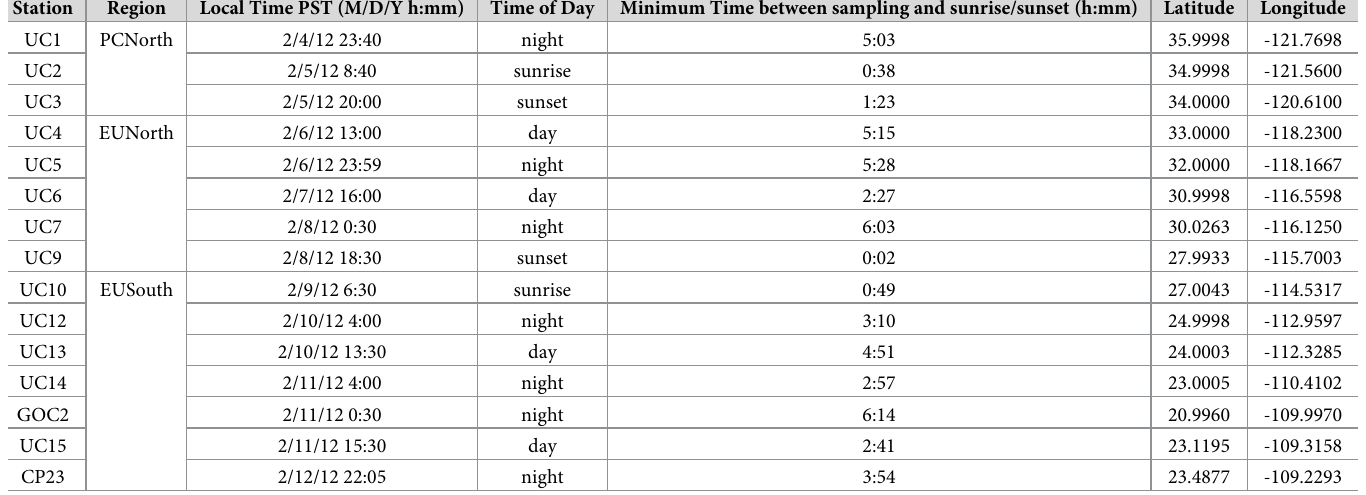
Table 1. Sampling station locations and times.